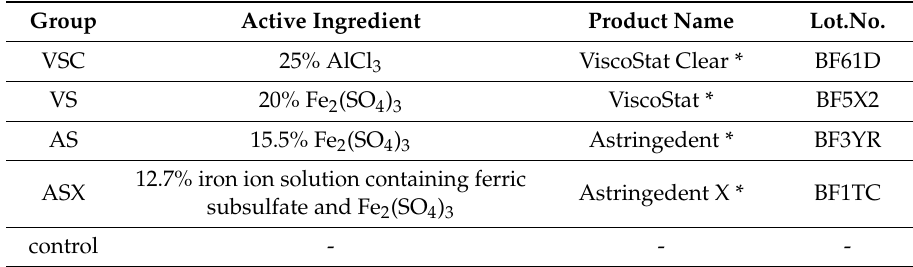
Table 1. Overview of test groups with respective hemostatic agents.